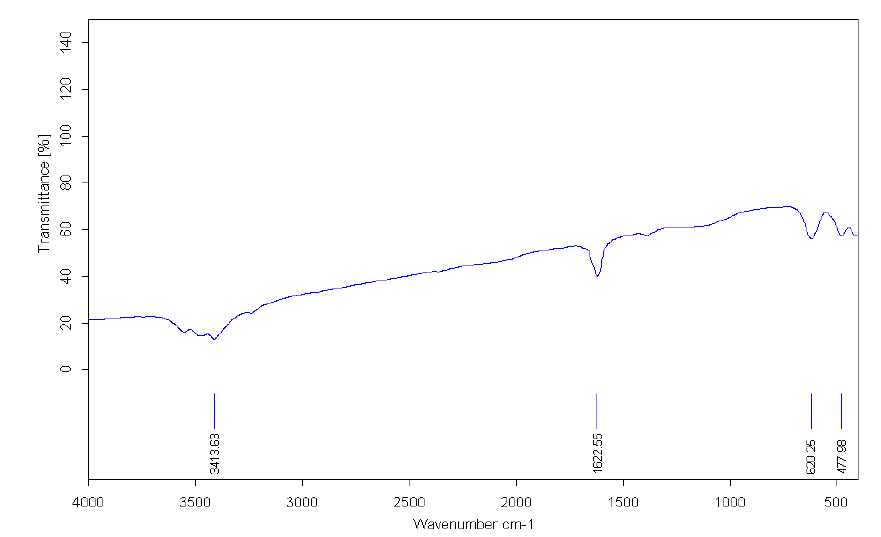
Figure 2. FT-IR Spectrum of Se NPs.